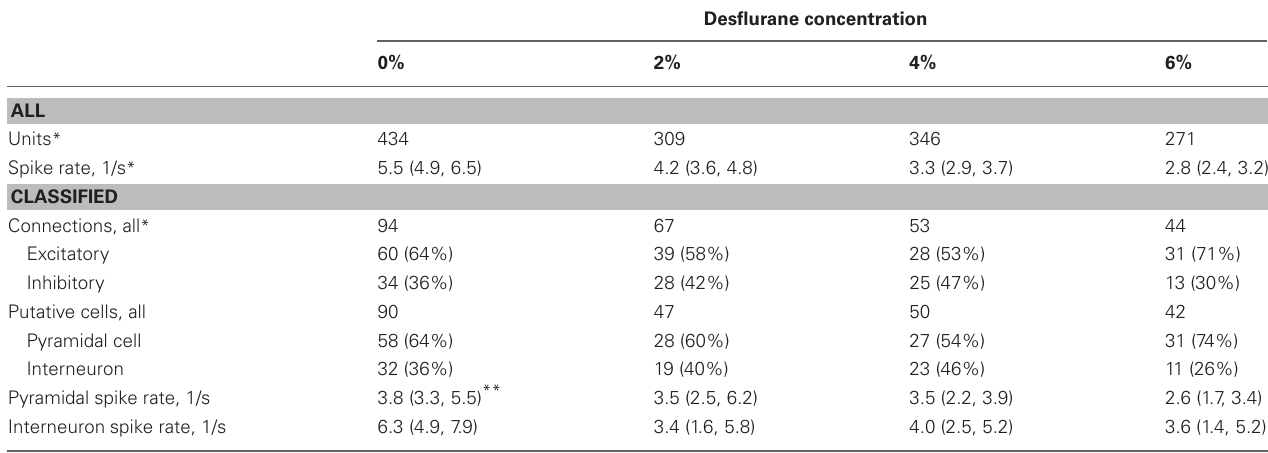
Table 1 | Properties of classified units and connections used for CCG analysis from seven